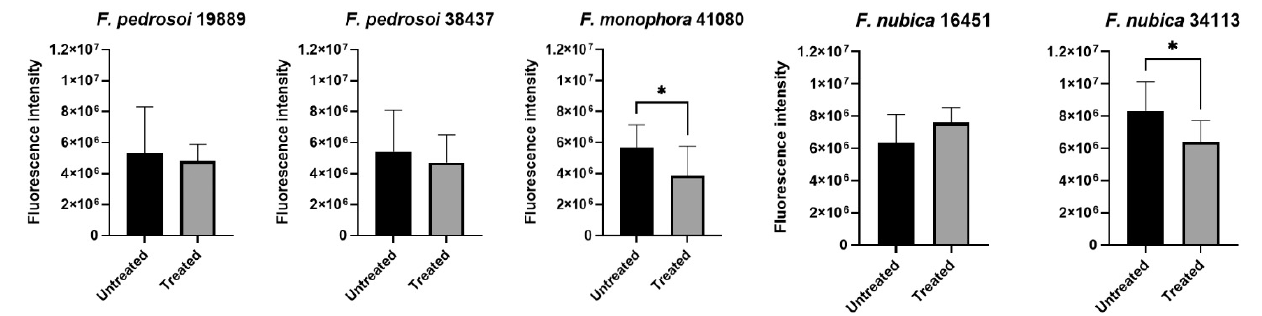
Figure 3. Chitin contents in five Fonsecaea spp. strains. Graphs present the mean fluorescence intensity of untreated (black bars) and treated (gray bars) conidia of five Fonsecaea spp. strains after Uvitex 2B incubation. * indicates significant difference ( p < 0.05).